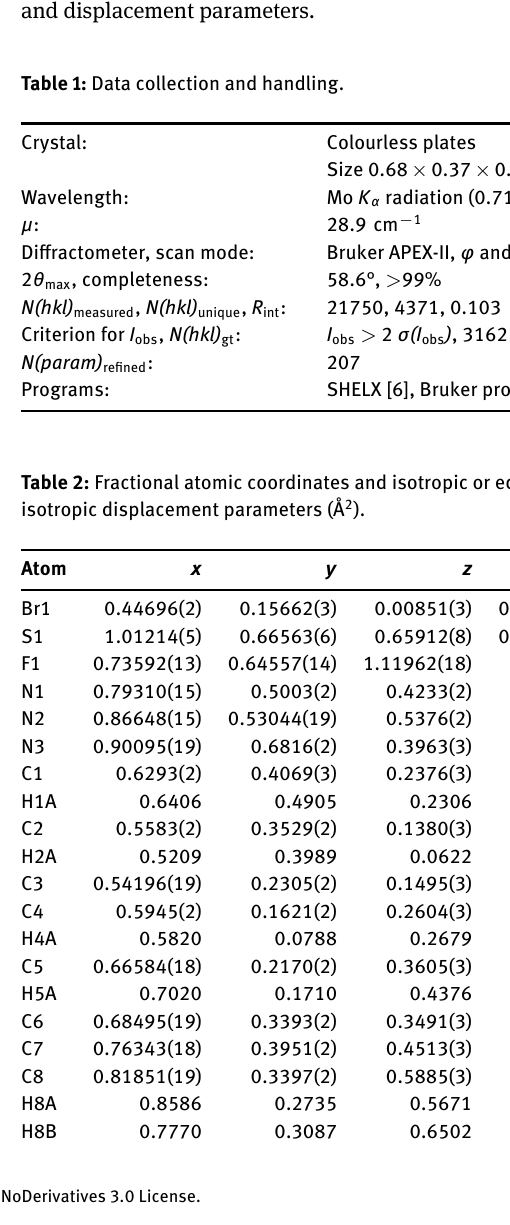
The asymmetric unit of the title crystal structure is shown in the figure. Tables 1 and 2 contain details of the measurement method and a list of the atoms including atomic coordinates and displacement parameters.